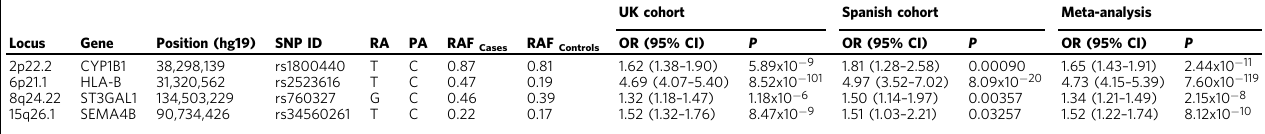
Table 1 Genome-wide signi fi cant loci for UK, Spain and meta-analysis